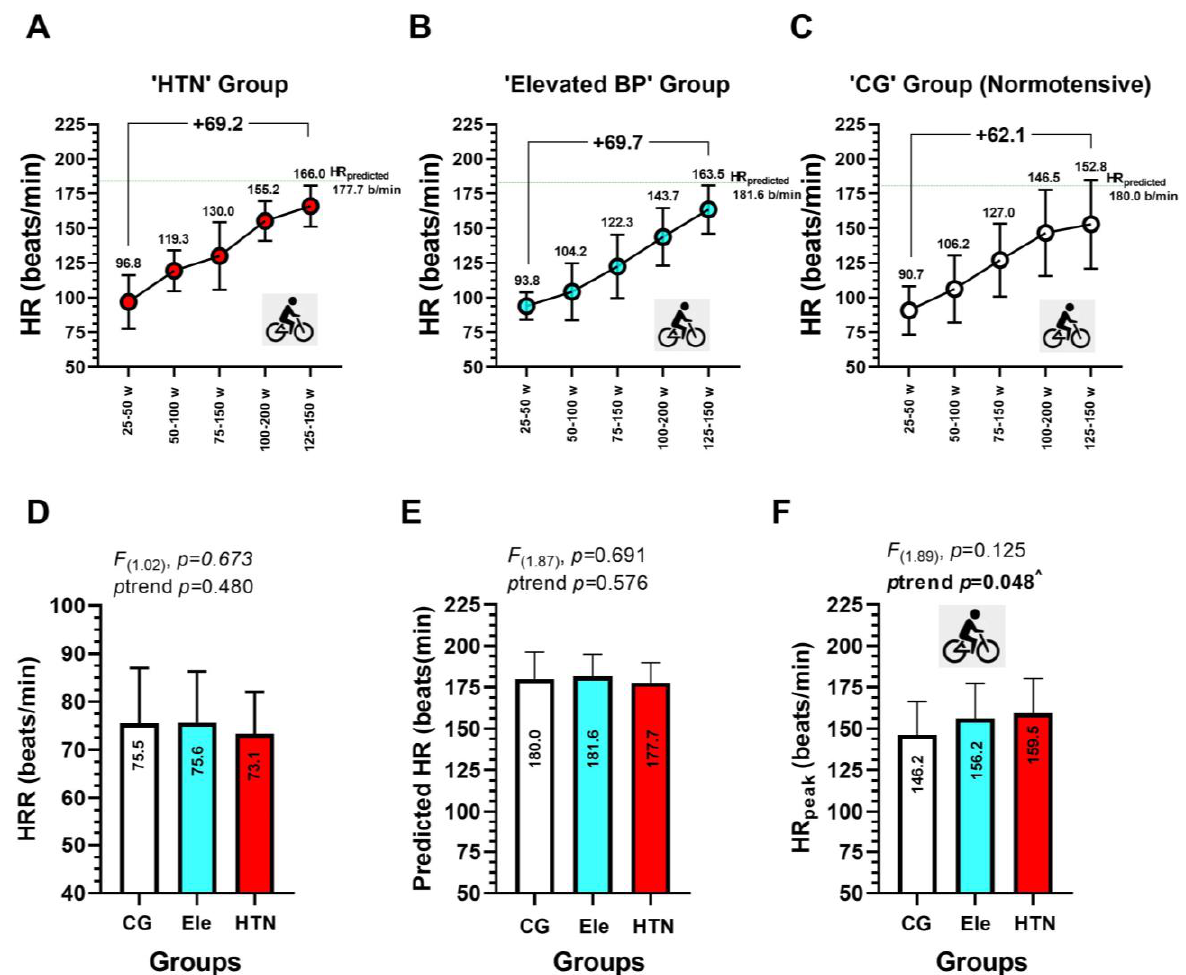
Figure 5. Heart rate outcomes during a progressive volitional cycling test in arterial hypertension (panel A ), elevated blood pressure (panel B ), and at the normotensive state (panel C ). Heart rate at rest is shown in (panel D ), heart rate predicted (220-age) is shown in panel ( E ), and heart rate peak in shown in panel ( F ). ^ Denotes a significant trend across groups at p < 0.05.